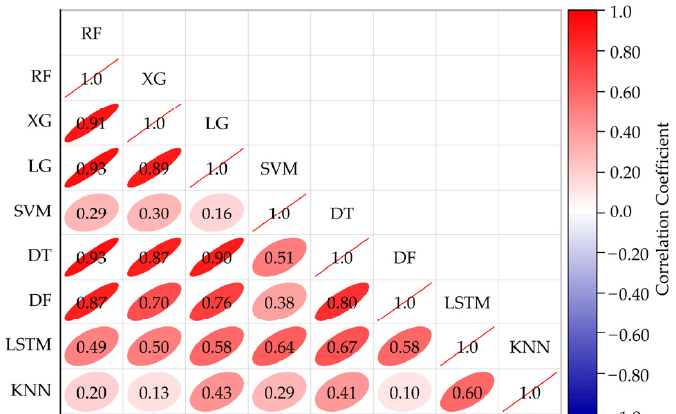
Figure 7. Matrix of correlation coefficients for the value of the classification prediction indicator between classifiers.